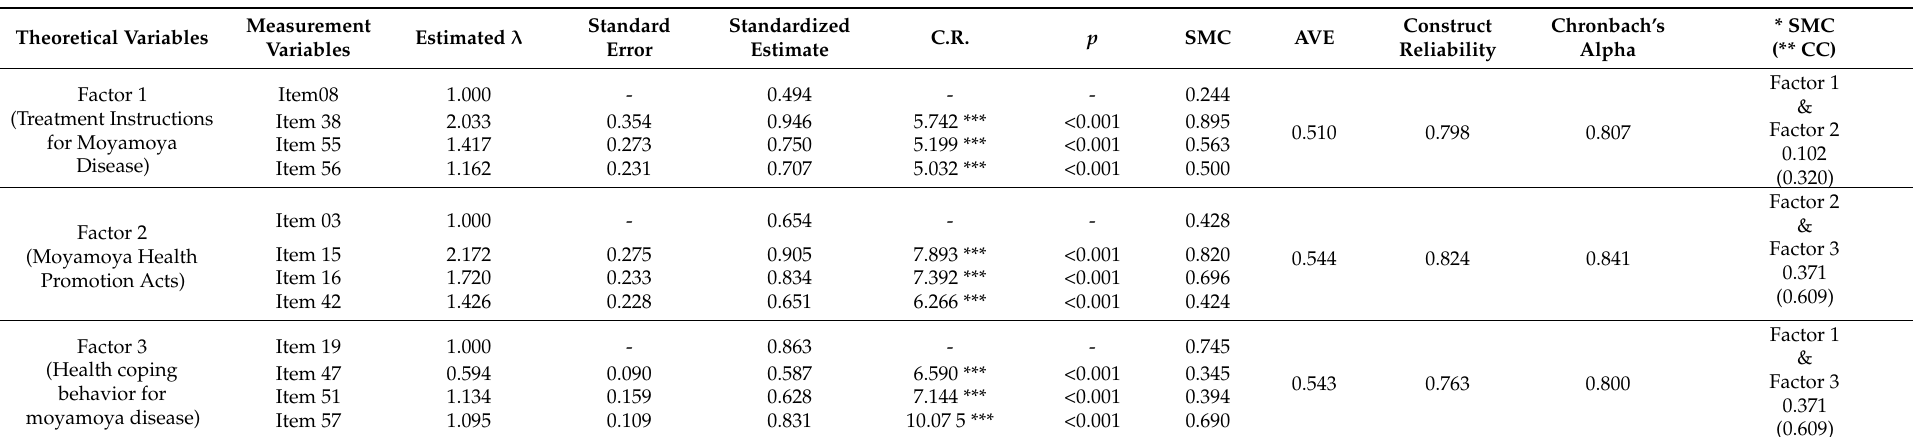
Table 3. Convergent/Discriminant Validity and Reliability from